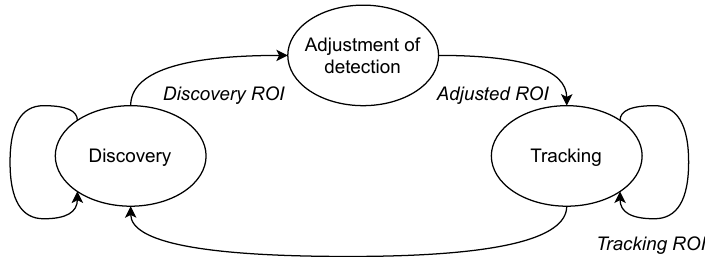
Figure 4. Diagram of the discovery and tracking proposed